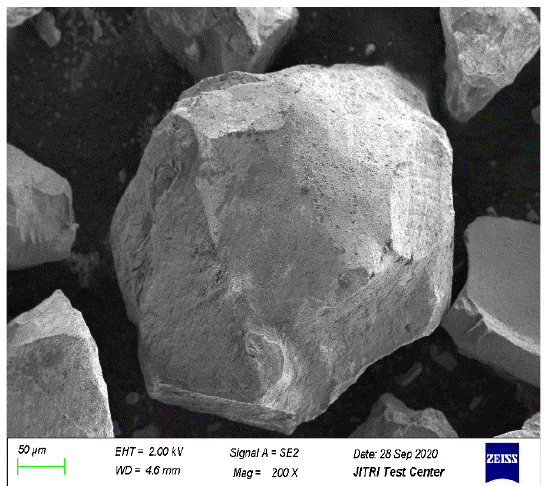
Figure 2. SEM image of magnetite particle.